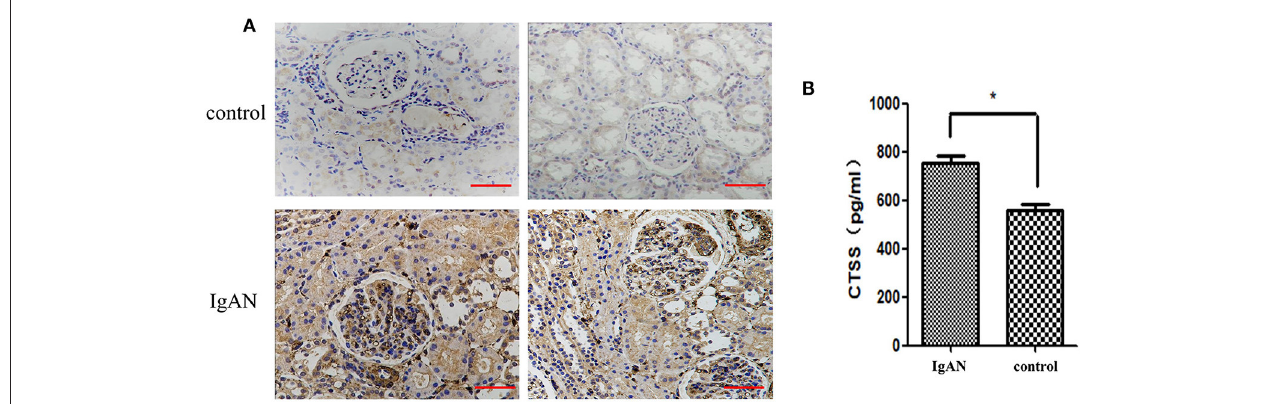
FIGURE 1 | Higher levels CTSS are detected in renal tissues and serum samples of children with IgAN. (A) Immunohistochemical analysis of CTSS in human renal tissues. Scale bar = 50 µ m. N = 25 patients, N = 8 control non-IgAN patients. (B) ELISA analysis of serum CTSS ( N = 25 for IgAN patients and healthy children, respectively). Data are representative images (magnification × 400) or expressed as means ± SD of each group from at least three separate experiments. * P < 0.05 vs. the